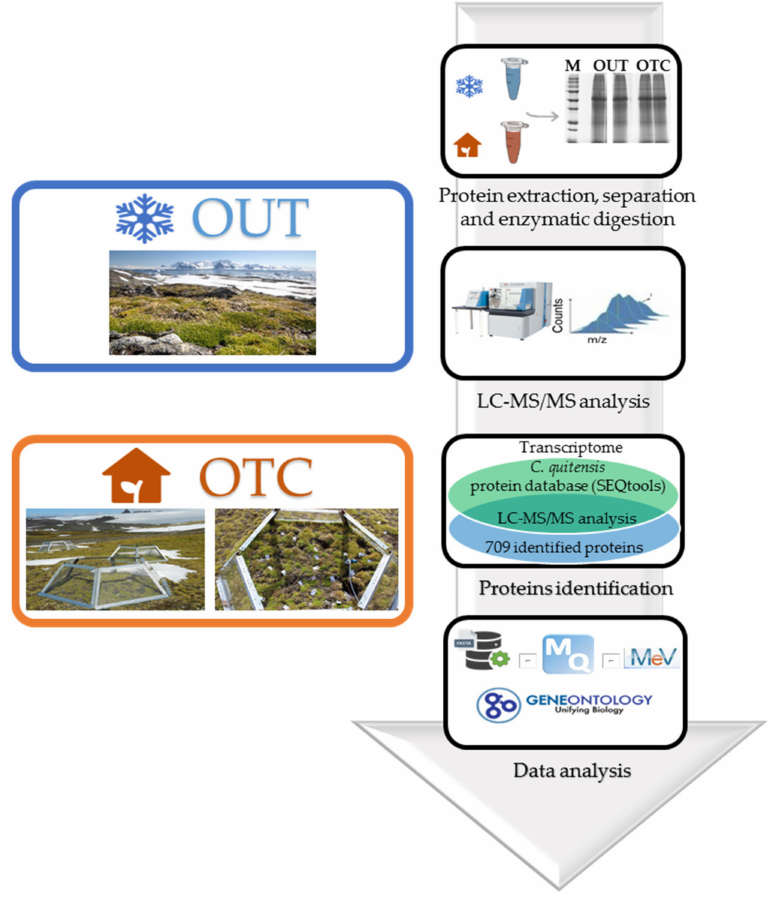
Figure 1. Experimental workflow. The open top chambers used in the experiment are